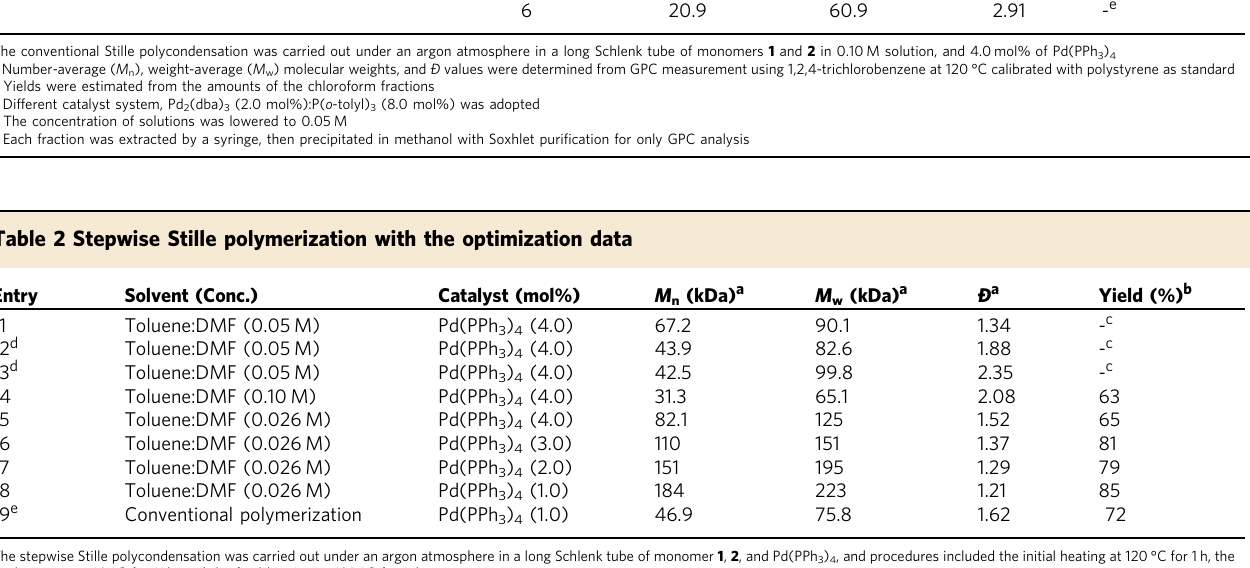
The stepwise Stille polycondensation was carried out under an argon atmosphere in a long Schlenktube of monomer 1 , 2 , and Pd(PPh 3 ) 4 , and procedures included the initial heating at 120°C for 1h, the cooling step at 60°C for 11h, and the fi nal heating at 120°C for 1day a M n , M w , and Ð values were determined from GPC measurement using 1,2,4-trichlorobenzene at 120°C calibrated with polystyrene as standard b Yields were estimated from the amounts of the chloroform fractions c Each fraction was extracted by a syringe, then precipitated in methanol with Soxhlet puri fi cation for only GPC analysis d The cooling temperature was investigated at 80 and 100°C for entries 12 and 13, respectively e 1.0mol%PdcatalystwasemployedforconventionalStillepolymerization.Amixtureofmonomer 1 , 2 ,andPd(PPh 3 ) 4 inabinarysolventof tolueneandDMF(4:1 vol%,0.026M)wasreactedat120°C for 1 day in a long Schlenk tube under an argon condition